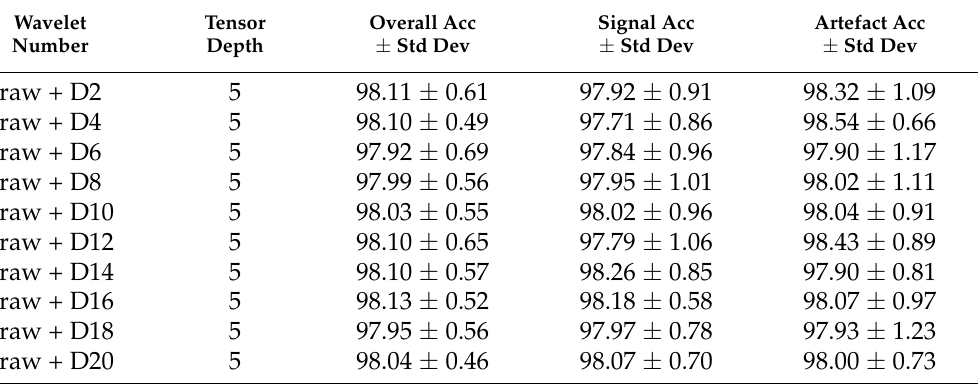
Table 9. Base CNN model performance for various single wavelet transformations applied to input data. Input tensor composed of a greyscale image and wavelet image components ( a , v , h , d ) set in a sequence which gives a tensor depth of 1 + 4. Results have been estimated using repeated k-fold validation (5 rounds with 5 folds each).